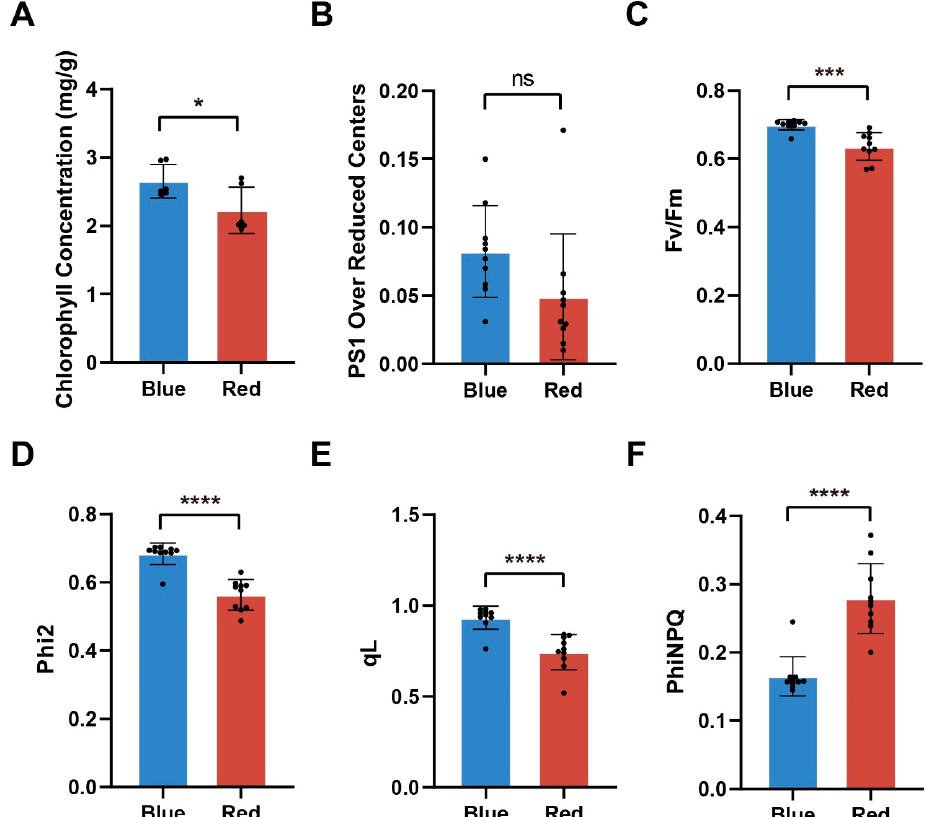
Figure 6. Comparison of chlorophyll content and fluorescence kinetic parameters of moso bamboo seedlings under red and blue light. ( A – F ) Chlorophyll concentrations ( A ), PS1 over reduced centers ( B ), Fv/Fm ( C ), Phi2 ( D ), qL ( E ) and PhiNPQ ( F ) for moso bamboo seedlings under different light treatments. Data are presented as mean ± SD ( n = 10 biological replicates). Significant differences were analyzed by two-tailed Student’s t -test ( ns p > 0.05, * p < 0.05, *** p < 0.001, **** p < 0.0001). 2.6. Effects of Blue and Red Light on the Metabolic Pathways of Soluble Sugars and Starch in Moso Bamboo Seedlings In the GO enrichment analysis of blue and red light co-responsive proteins and red light-specific responsive proteins, sugar and carbohydrate metabolism were significantly enriched (Figure 4B,D). As soluble sugars and starch play important roles in plant growth metabolism [31–33], we analyzed the expression patterns of light-responsive proteins related to sugar metabolism. Both blue and red light up-regulated the expres- sion of light-responsive proteins in the soluble sugar and starch pathways compared to darkness (Figure 7 and Table S4). To compare the expression differences of these pro- teins under red and blue light more intuitively, we calculated the fold change of their expression levels between red and blue light conditions (Figure S7). We found that there were two cellulose synthetases CESA (CELLULOSE SYNTHASE) (PH02Gene24001 and